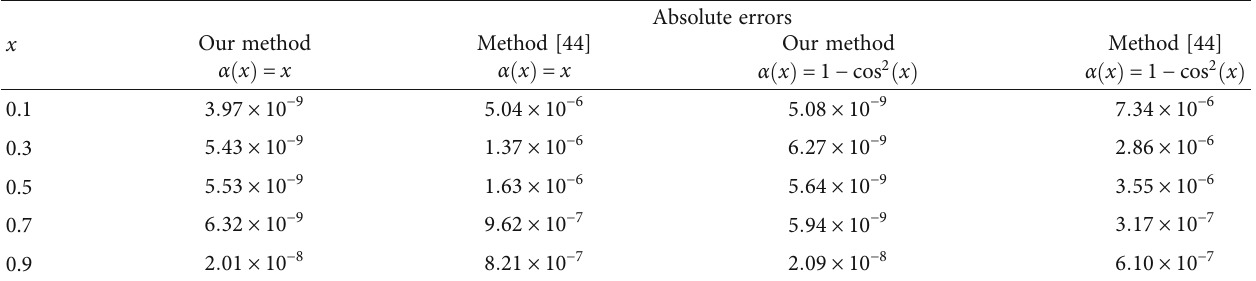
Table 2: The comparisons between the absolute errors of the method given in [44] the presented method with di ff erent values of α ð x Þ , τ and N = 7 for Example 2.